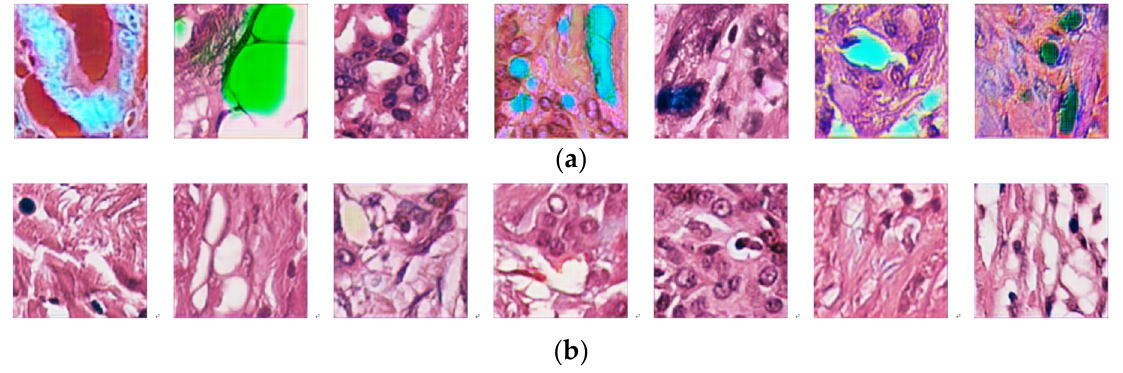
Figure 12. Seven randomly selected snapshots from network outcomes of seven independent runs, ( a ) without and ( b ) with the specialized color classifier using S3CGAN architecture.